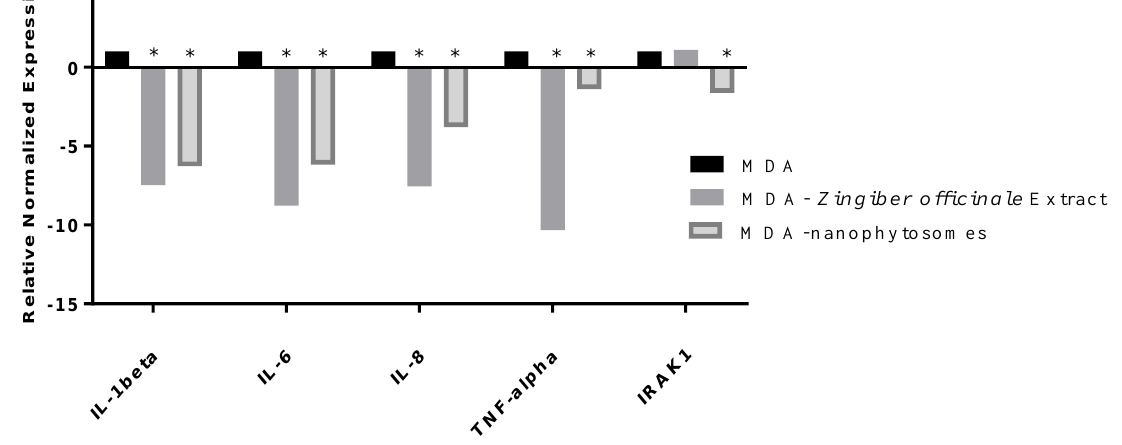
Figure 5. Effect of Zingiber officinale extract and 6-gingerol-loaded PEGylated nanophytosomes on the expression of IL-1beta, IL-6, IL-8, TNF-alpha, and IRAK1 on MDA cells compared with control (cells only). The crude extract as well as the pure compound 6-gingerol have significantly ( p < 0.05) downregulated factors (TNF- α , IL-1beta, IL-6, IL-8, and IRAK1) in MDA after being separately loaded in PEGylated nanophytosomes. * Statistically different at significance level p < 0.05.